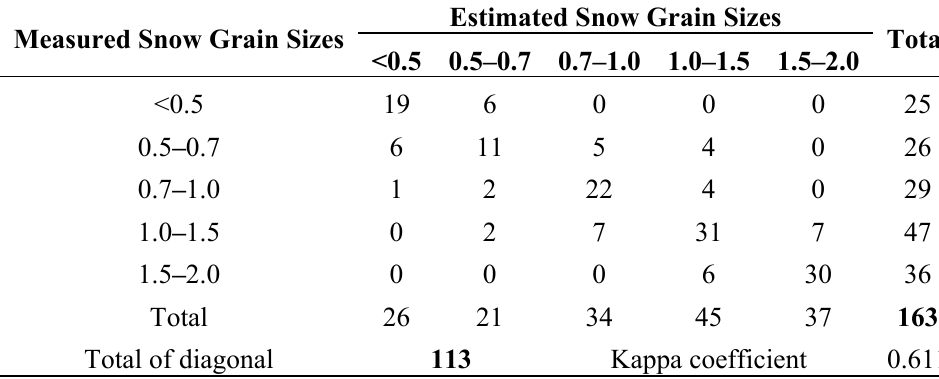
Table 1. Kappa coefficient of the estimate